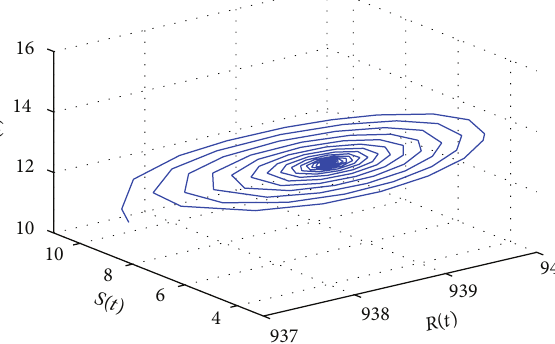
Figure 2: The phase plot of the states 𝑆 , 𝐼 , and 𝑅 for 𝜏 = 1.3025 < 1.3265 = 𝜏 0 .